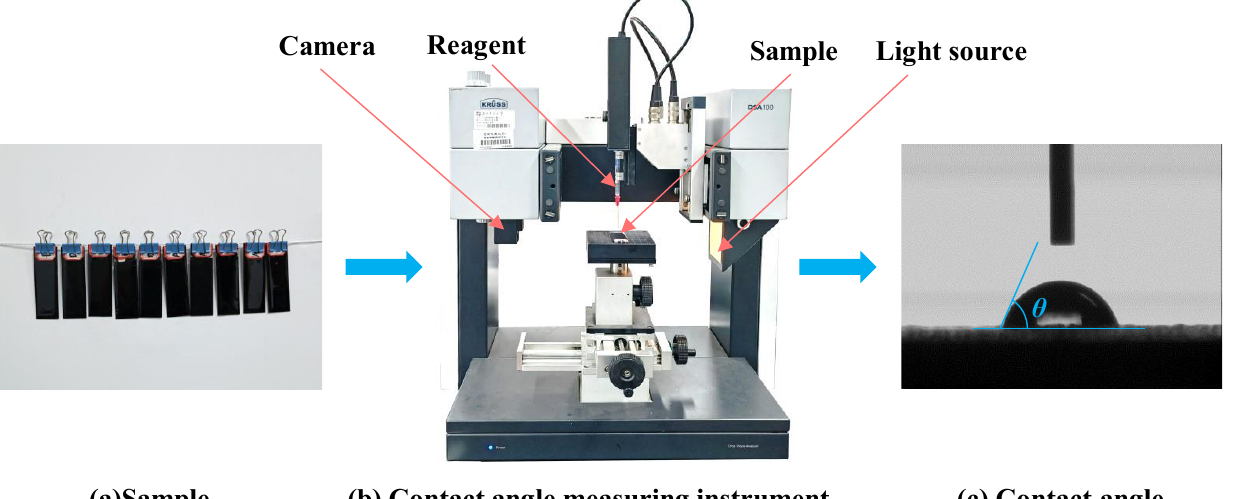
Figure 4. Contact angle measurement method. ( a ) Sample preparation; ( b ) Contact angle measuring instrument; ( c ) Contact angle